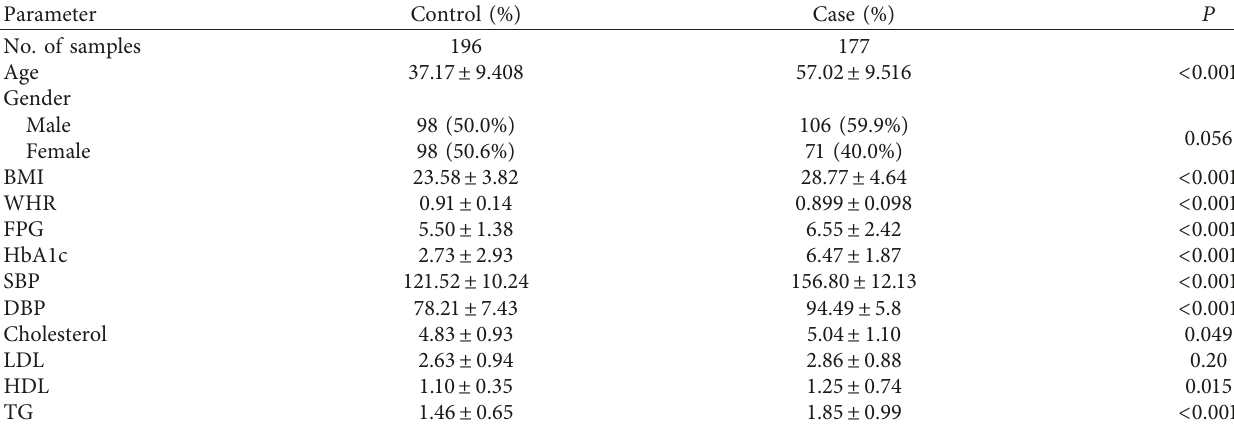
Table 1: Clinical and biochemical parameter of EH patients and control